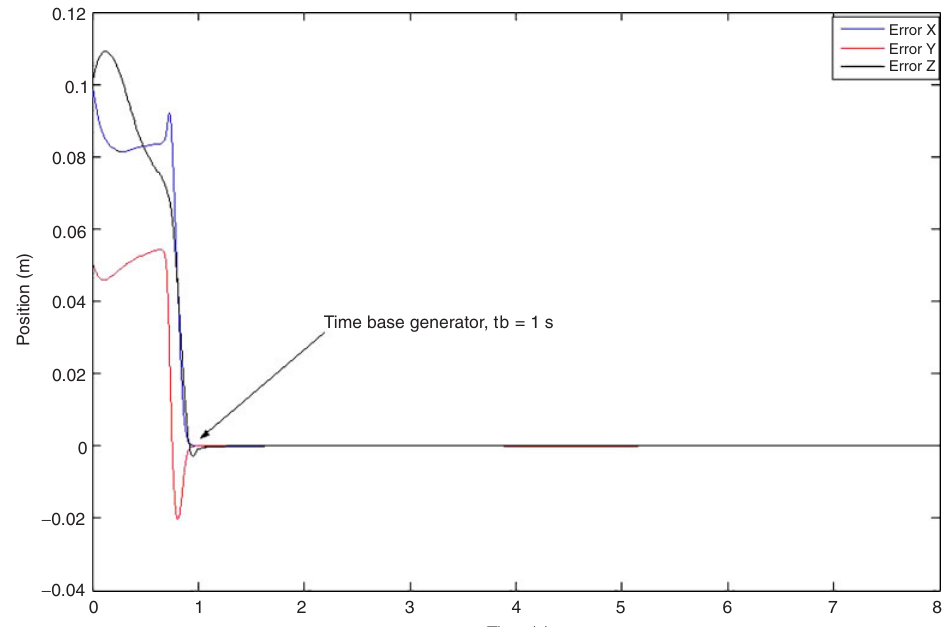
Figure 9 Cartesian error in X , Y and Z (tracking in t b = 1 s).